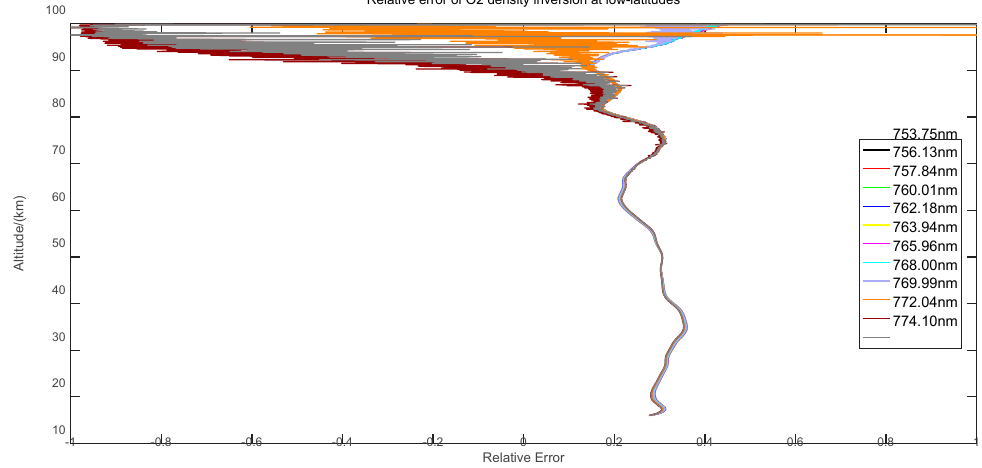
Figure 7. Relative deviation of oxygen number density retrieved by different wavelengths. By analyzing the absolute deviation, it is found that the inversion results of all wave- lengths decrease with height. At the altitude of 85–100 km, the absolute deviation of 769.99–774 nm is lower than that of other wavelengths, and the results of other wave- lengths are the same. The relative deviation results are as follow: the maximum deviation is approximately 30% at 14–95 km, and the deviation is large at 95–100 km. The causes of deviation are as follows: (1) SABER’s own detection data error; (2) The number density of measured oxygen is obtained from the atmospheric density × 0.21. As the proportion of oxygen is not completely fixed with the increase in height, there is a large deviation of approximately 100 km; (3) The error of the onion-peeling method in inversion; (4)